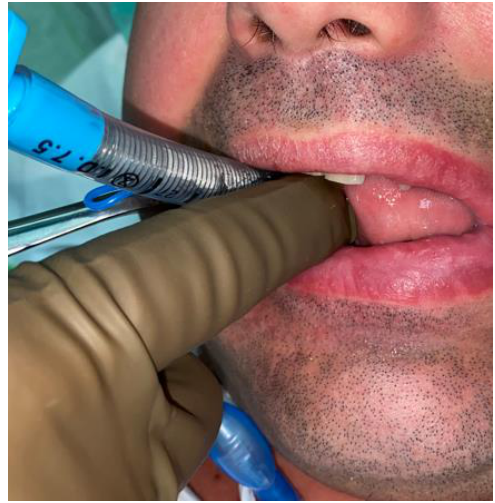
Figure 17. Difficult airway safety was achieved with endoscopically assisted intraoral intubation and proper anesthesia to release muscular tensions.